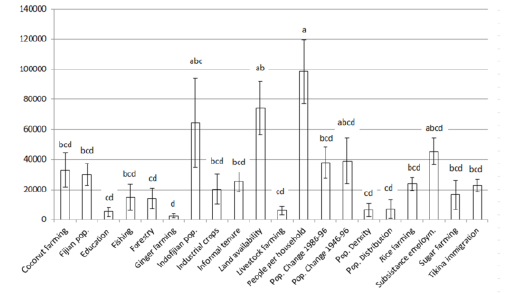
Figure 19. Total of pixels of areas with high or very high values of LUI per socio economic parameter. *Means that share the same letter represent not significant differences between them